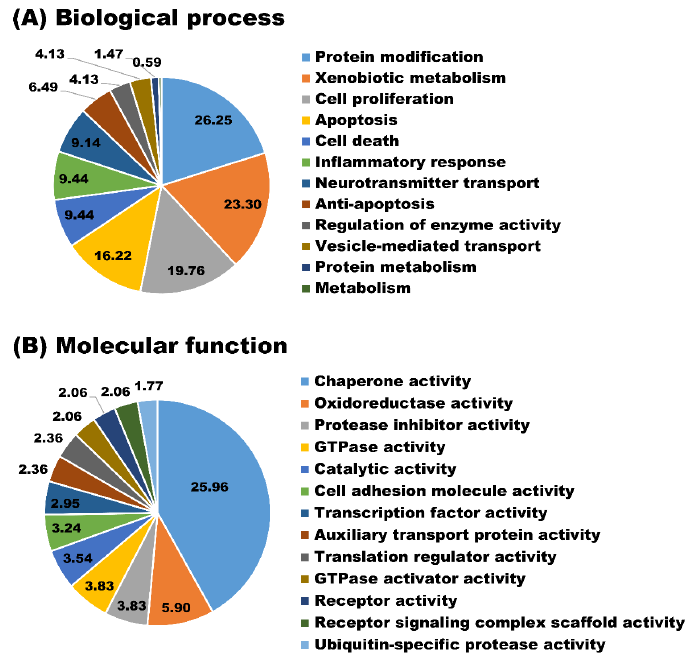
Figure 5. GO analyses. Biological process ( A ) and molecular function ( B ) of newly identified proteins in milk sEVs.